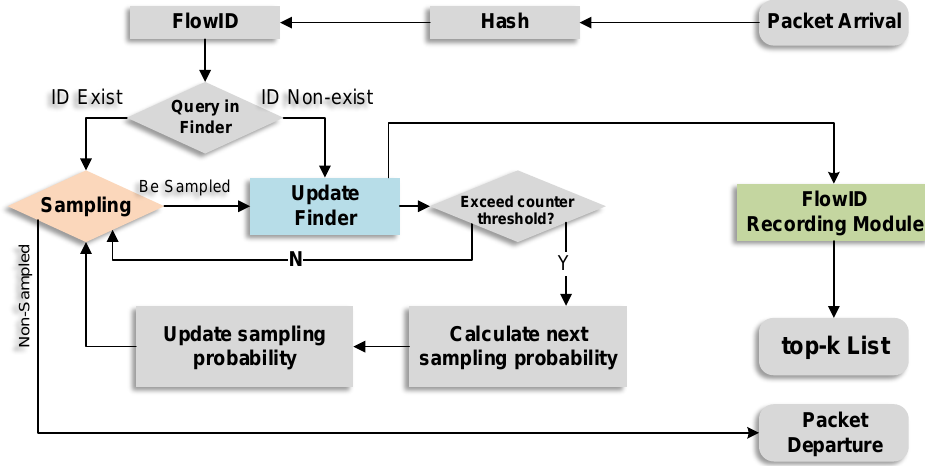
Figure 7. The structure of the flow label recording module in